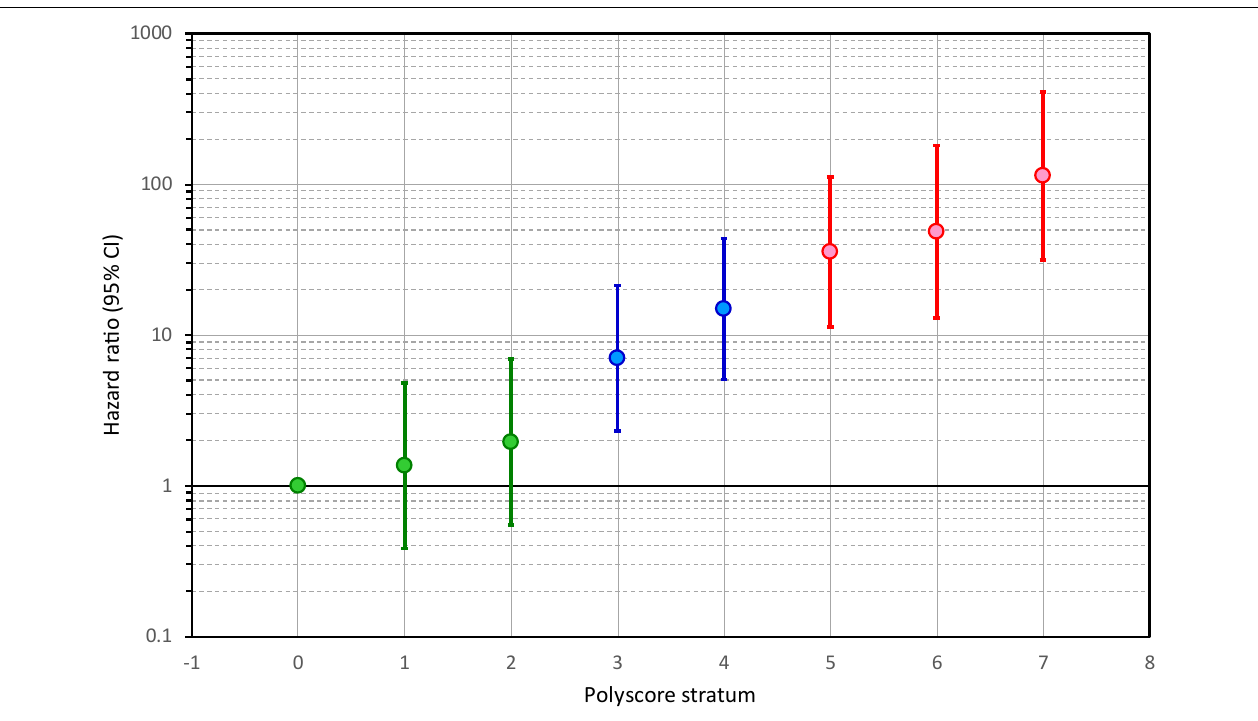
FIGURE 3 | Hazard ratios of individual Polyscore strata. For each stratum 1, 2, ... , 7, the figure shows the result of a univariable Cox regression model comparing the stratum with the lowest-risk stratum of Polyscore 0. The Hazard ratios are shown together with their 95% confidence intervals. Note the logarithmic scale of the vertical axis. Note also that the development of the hazard ratios allows defining a low-risk group of Polyscore ≤ 2 (shown in green), an intermediate risk group of Polyscore 3 or 4 (shown in blue), and a high-risk group of Polyscore ≥ 5 (shown in red). CI, confidence interval.